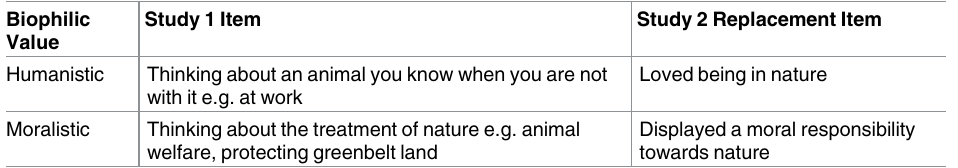
Table 8. Replacement biophilia activity items used in study 2.